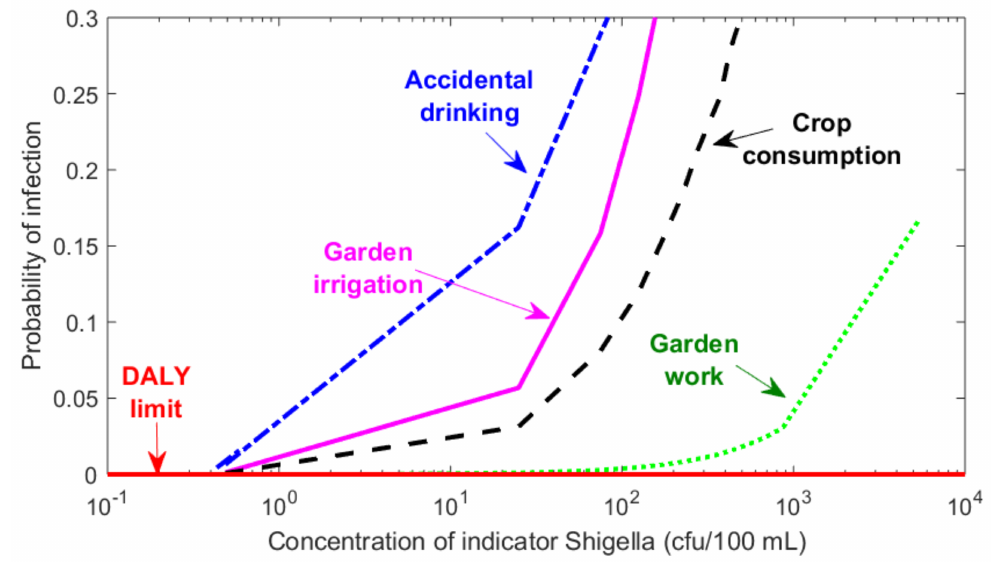
Figure 2. Probability of infection from Shigella spp. In greywater under four worst-case exposure scenarios (Table 2). The red solid horizontal line represents the DALY limit of acceptable risk as suggested by the WHO